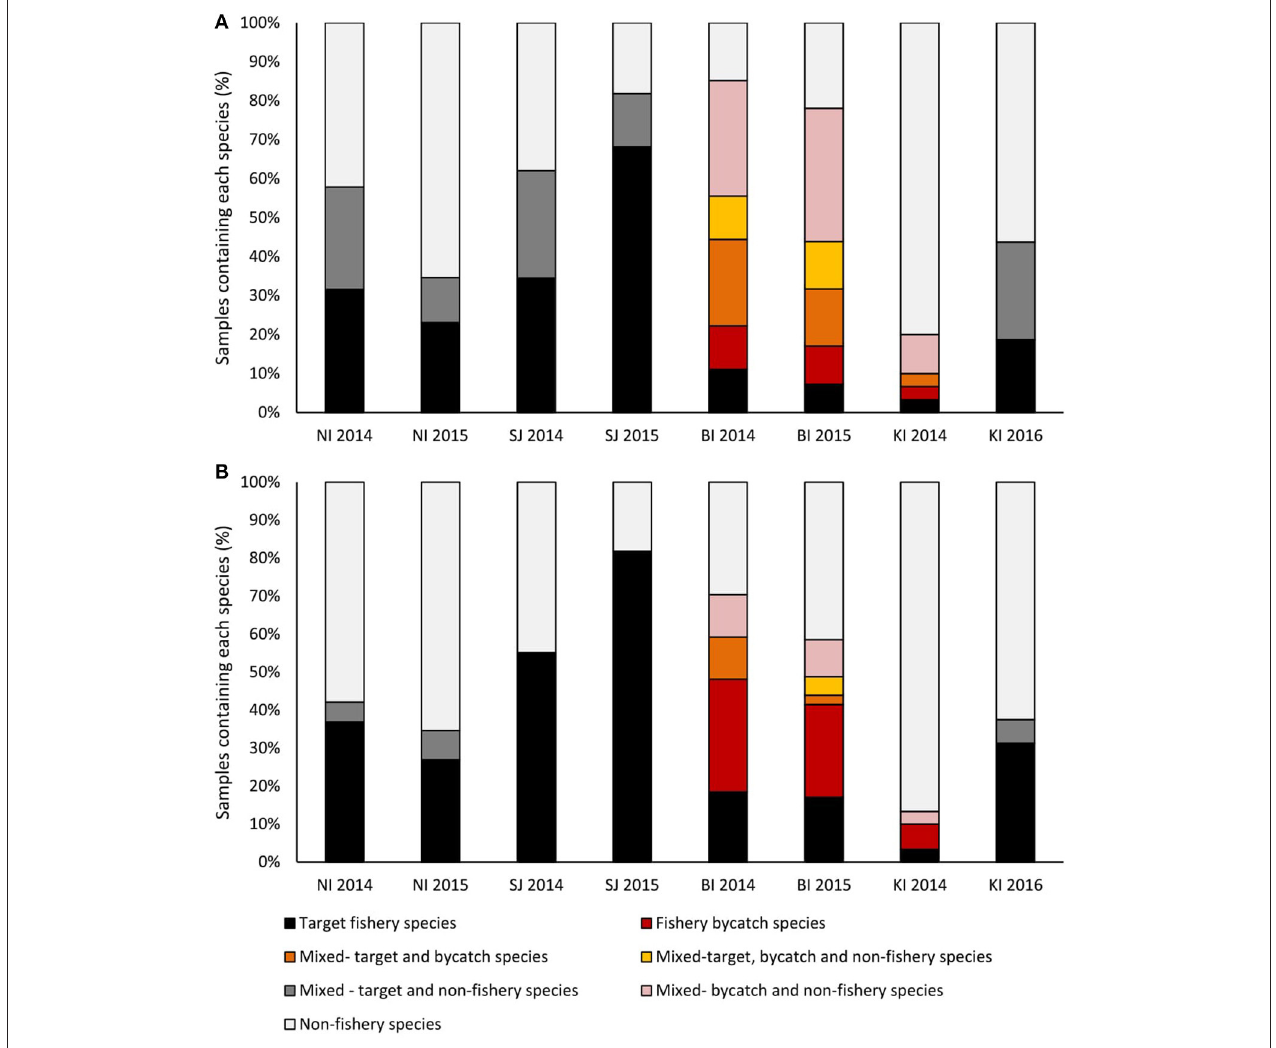
FIGURE 5 | The proportion of samples that contained target, bycatch or non-fishery species as either (A) > 1% of sequences in a sample, or (B) > 75% of the sequences in a sample. Samples with < 75% of sequences in any category were considered to be mixed. Bycatch species each constituted > 1% of the total catch. Sites were New Island (NI) and Steeple Jason Island (SJI), Falkland Islands; Bird Island, South Georgia (BI) and Canyon des Sourcils Noirs, Iles Kerguelen